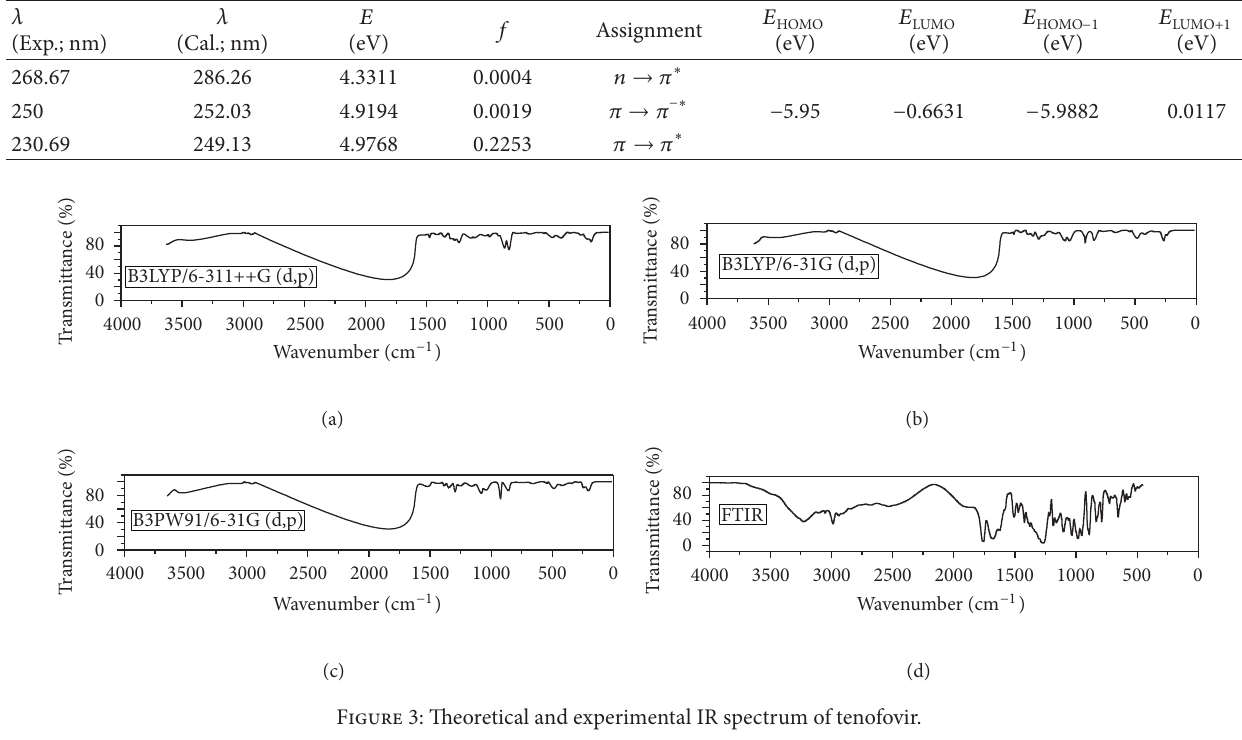
F 3: eoretical and experimental IR spectrum of tenofovir.